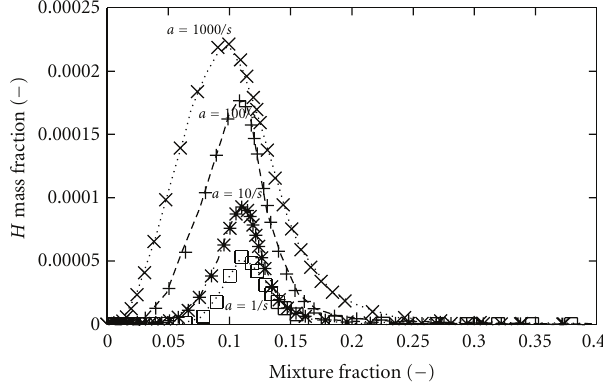
Figure 2: Comparison of predicted laminar flame speeds versus equivalence ratio at various pressures (1atm, 2atm, 6atm, 10atm, and 20 atm). Solid lines: detailed DME mechanism by Zhao et al. [10]; symbols: 28-species reduced chemistry (this work). Initial temperature: 300K.